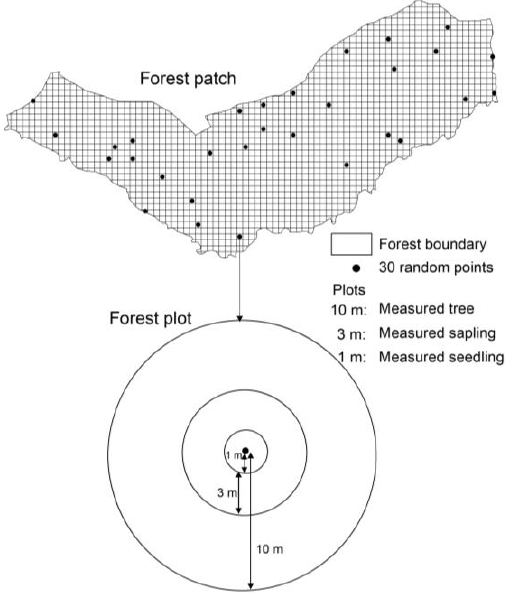
Figure 2. Circular plot method for sampling tree, sapling and seedling in each surveyed village.